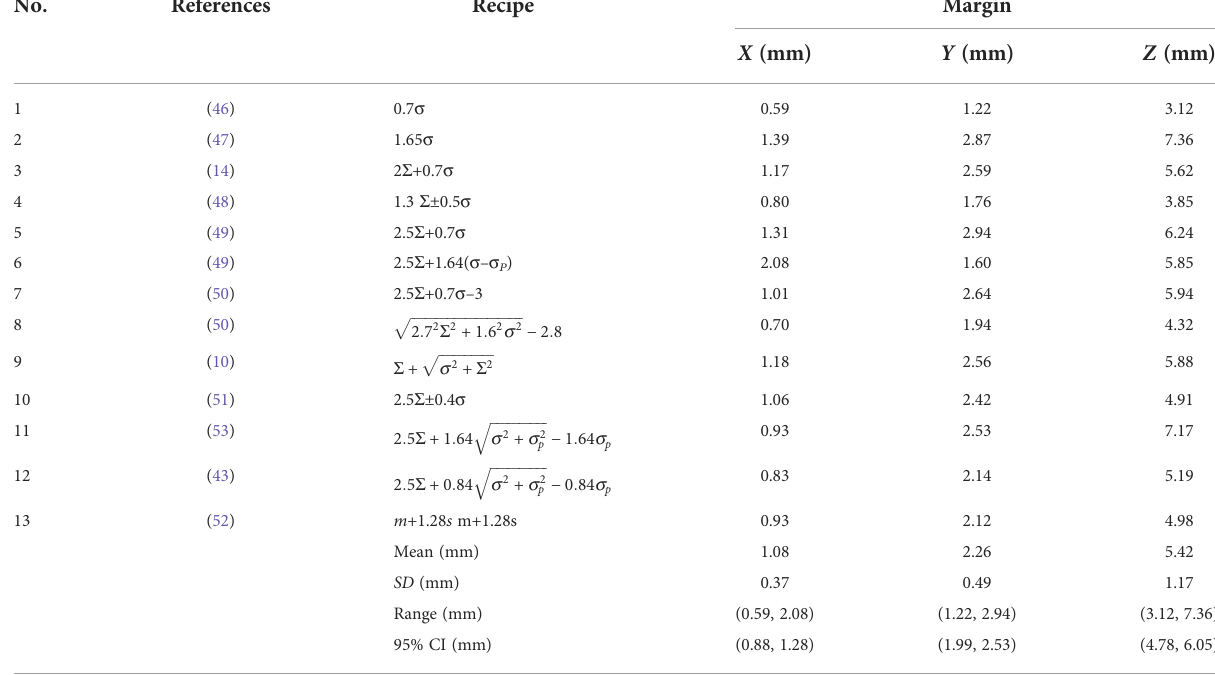
TABLE 1 Margins calculated based on published recipes for